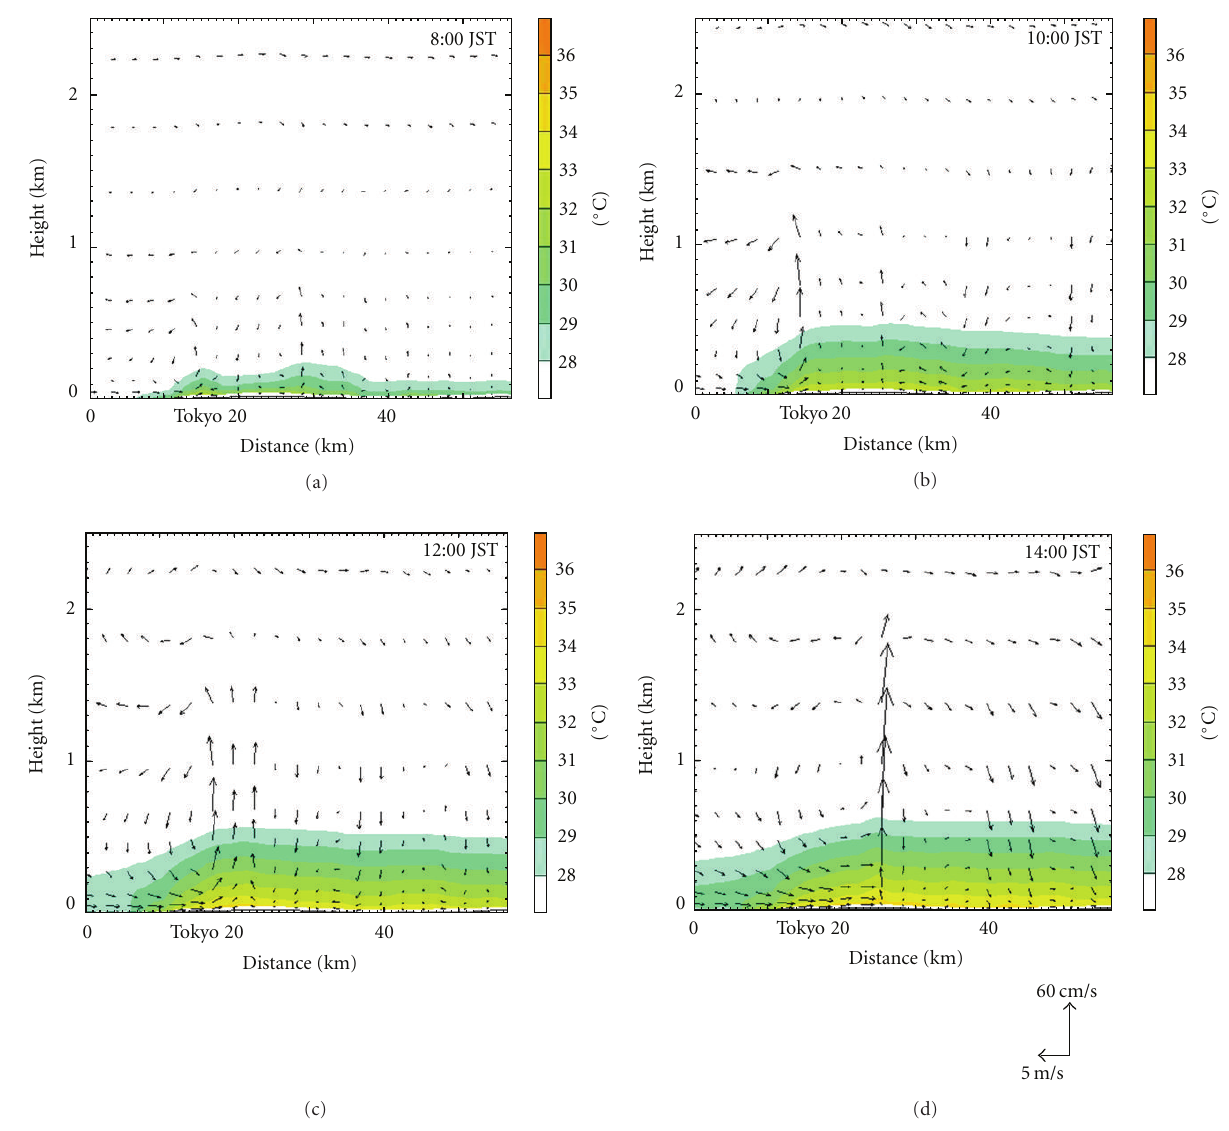
Figure 15: Circulation vectors and air temperatures on the plain, with cross section AA’, on August 4, 2005.